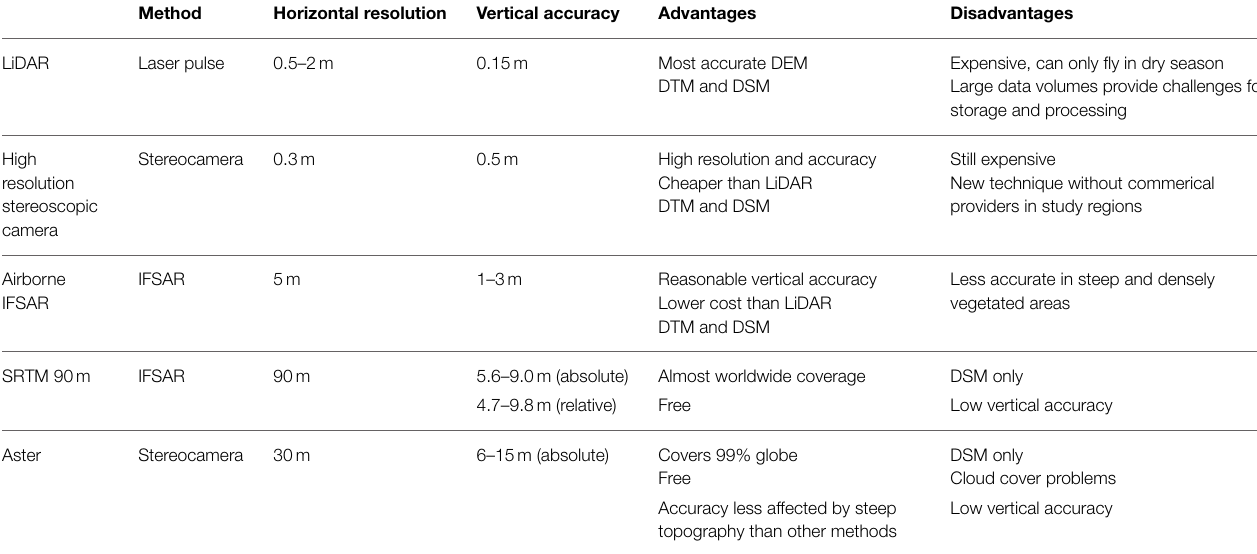
TABLE 1 | A comparison of different topographic data types used in this